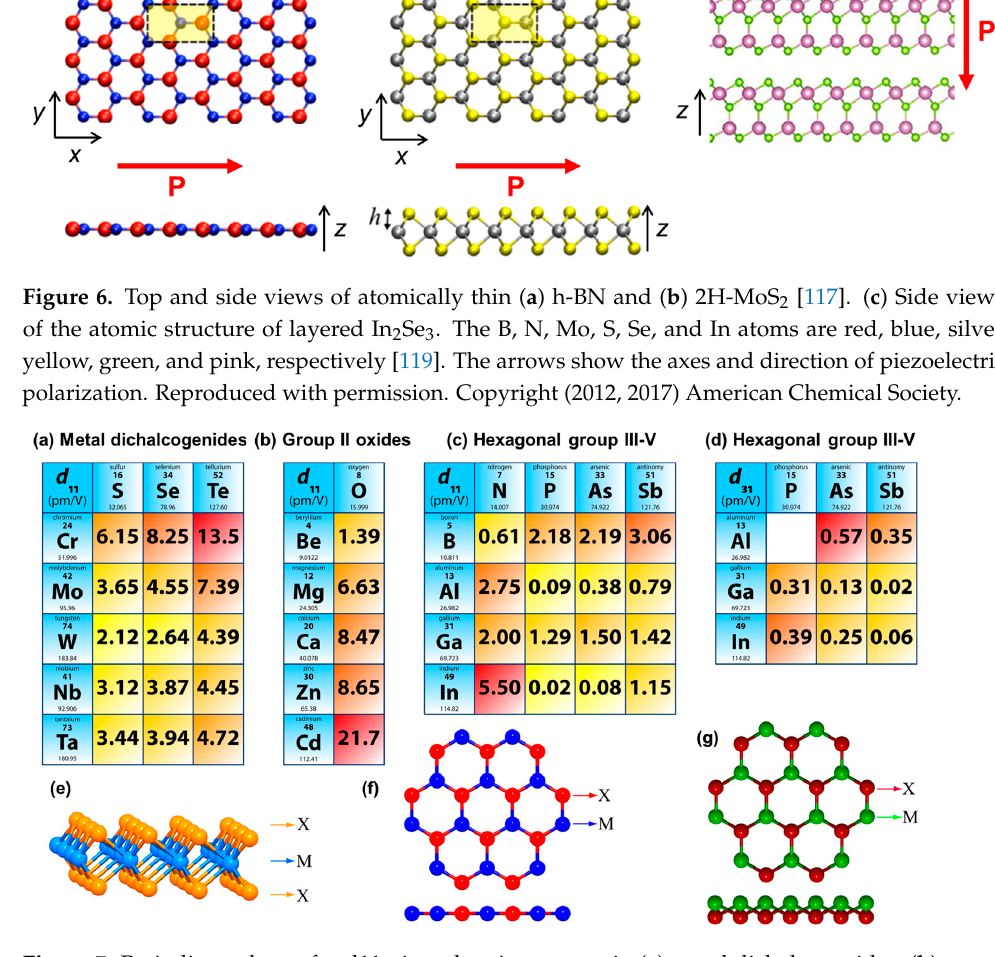
Figure 7. Periodic tendency for d11 piezoelectric constant in ( a ) metal dichalcogenides, ( b ) group II metal oxides, and ( c ) hexagonal group III-V semiconductors, and d31 piezoelectric constant in ( d ) hexagonal group III-V semiconductors. Schematic illustration of material structures: ( e ) 2H, ( f ) pla- nar hexagonal, and ( g ) buckled hexagonal structures [115]. Reprinted with permission. Copyright (2015) American Chemical